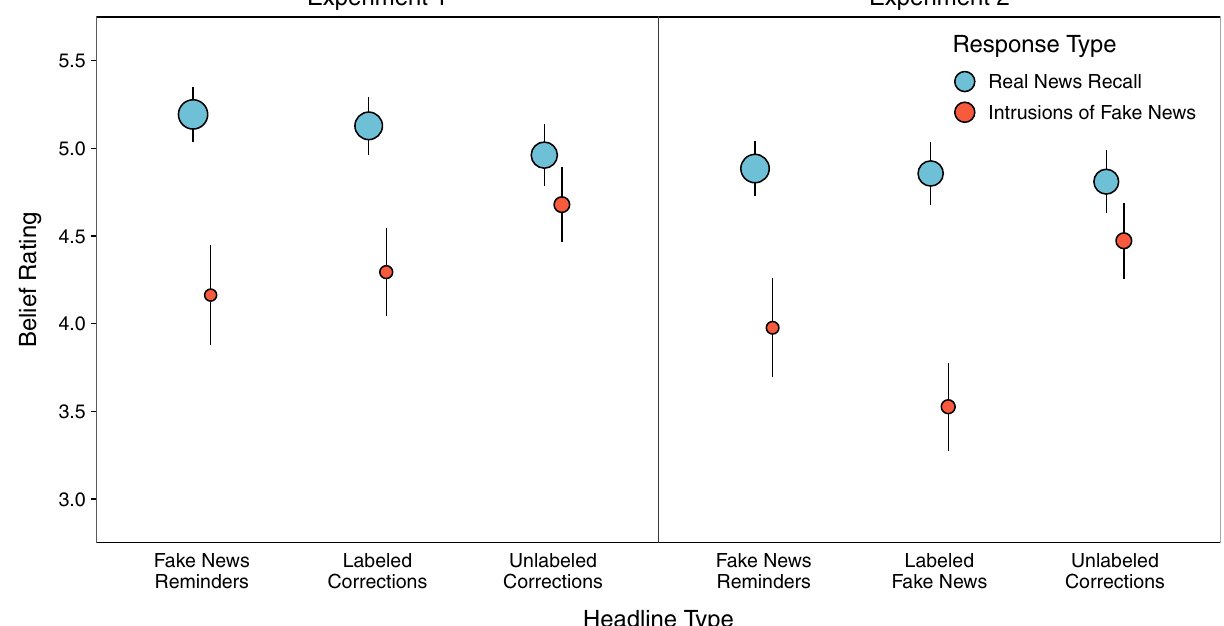
Figure 5. Beliefs in real news recall and intrusions of fake news for each correction headline type condition. Points are ratings estimated with mixed effects models, and error bars are 95% confidence intervals. Point sizes indicate for each cell the proportion of observations, which are also displayed in Supplementary Table S5.